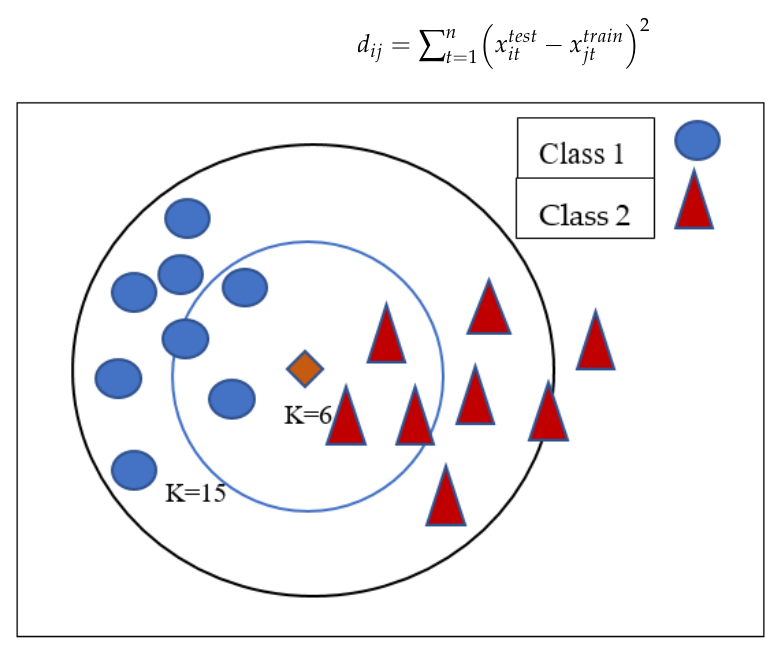
Figure 2. K -Nearest Neighbor.